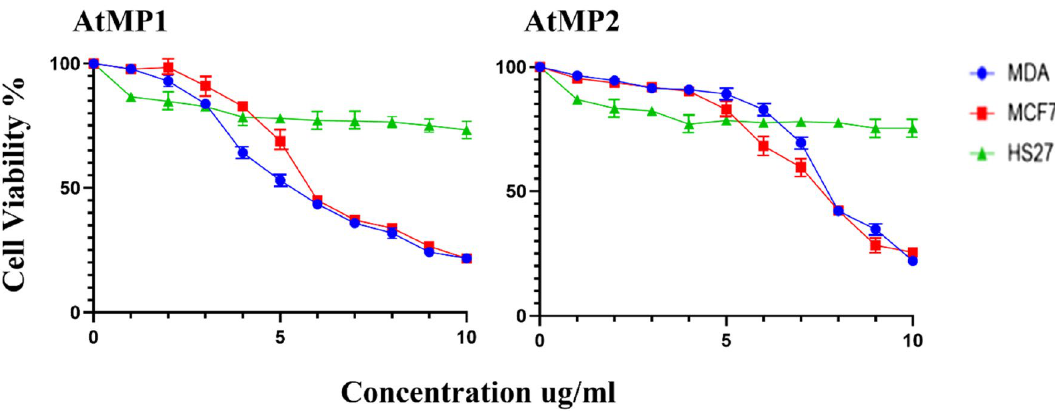
Figure 9. Cytotoxicity effect of synthesis AtMP1 and AtMP2 on cancer MDA-MB-231 and MCF7 cell line and HS27 normal cell lines. the cytotoxicity calculated and the results show the treatment was cytotoxic cancer cell line after 48 h. However, the treatment didn’t show effects against normal cell line (HS27). The graphs are representing cell viability (%) by measuring the absorbance of optical density (590 nm) with a microplate reader. Data are the mean ± SD of triplicate determinations. (Left) AtMP2. (Right)